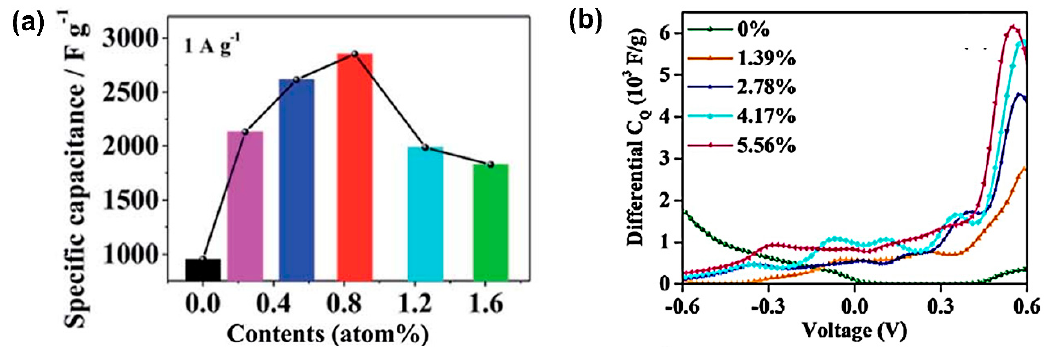
Figure 11. ( a ) The specific capacitances for CuS:Ce 3+ with different Ce doping concentrations at a current density of 1 A g − 1 : reproduced from Reference [180]. Copyright The Royal Society of Chemistry, 2019 ( b ) The calculated C Qdif of pristine and N − doped graphidyne at site II under different doping concentrations as a function of local electrode potential: reproduced from Reference [181]. Copyright Elsevier, 2020.